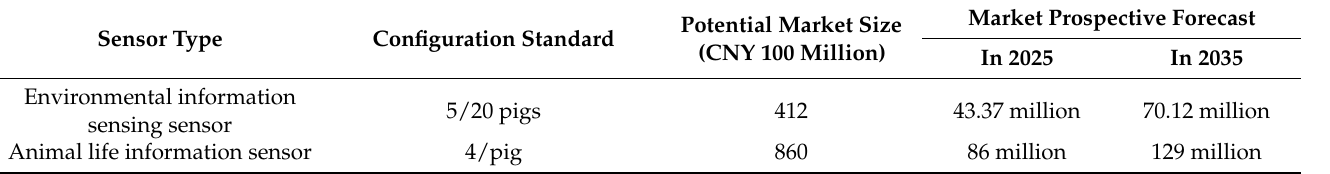
Table 7. Potential market scale and prospective forecast of sensors in the livestock breeding indus- try